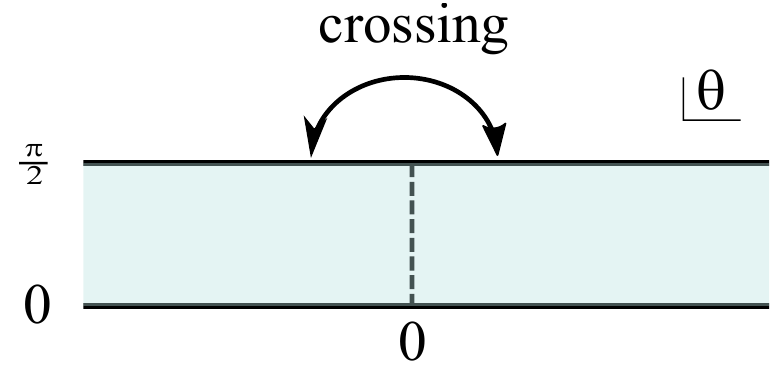
Figure 1 . Pictorial description of the 1 → 1 R-matrix describing the amplitude for a particle to bounce from the wall possibly changing its identity a → b . A double Wick rotation relates this process to pair production from an initial boundary state | B i . In the second case we can define a bulk S-matrix using the usual asymptotic states.